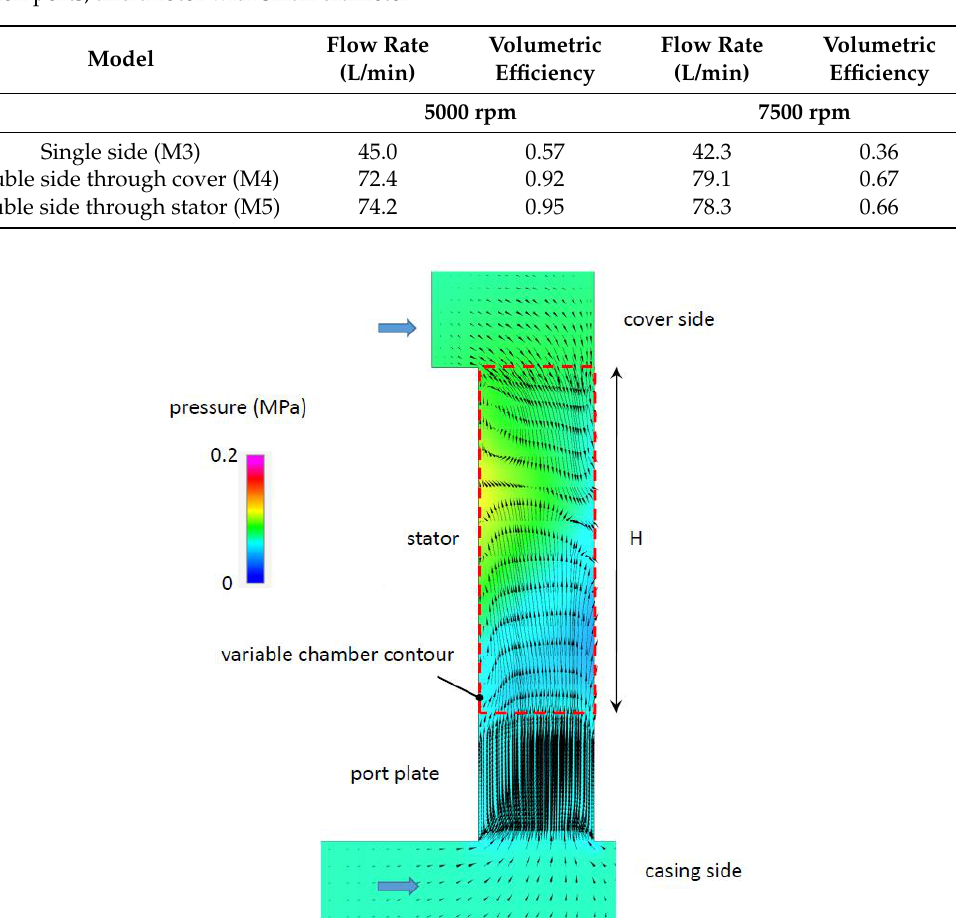
Table 6. Parameters of the pump with respect to the unit M0.